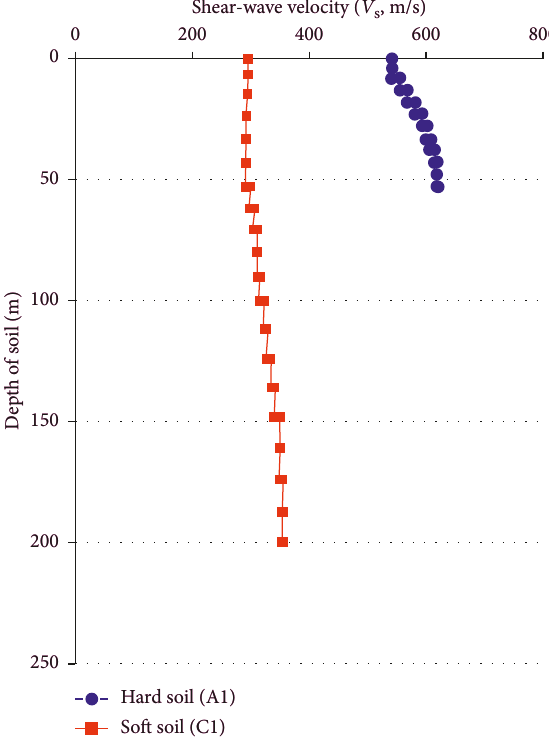
Figure 3: Soil profile: A1 and C1